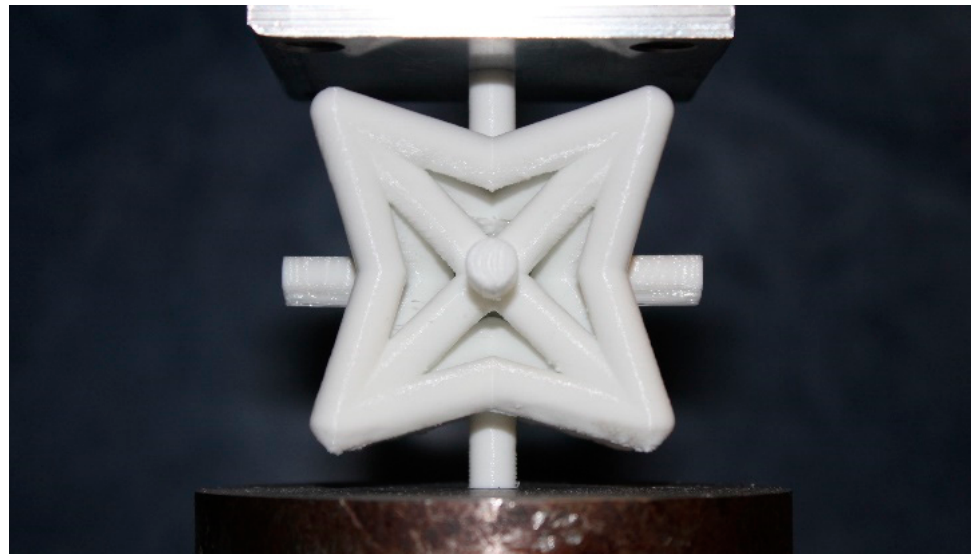
Figure 8. An additively manufactured specimen with 𝜇 = 0.25 under loading test.